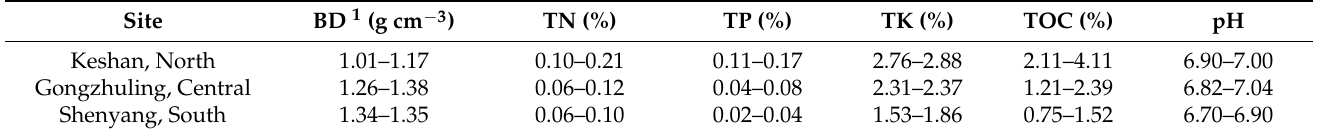
Figure 1. Distribution of experimental stations selected for this study. Table 1. Soil parameters (0–40 cm) of the three stations in Northeast China Plain.